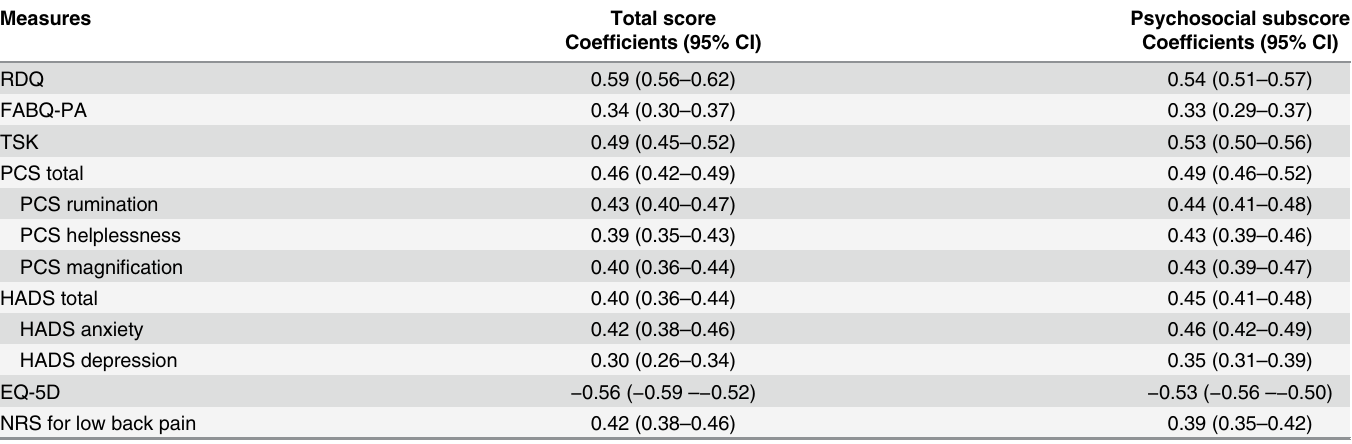
Table 3. Spearman ’ s correlation coefficients for the STarT-J and related measures.